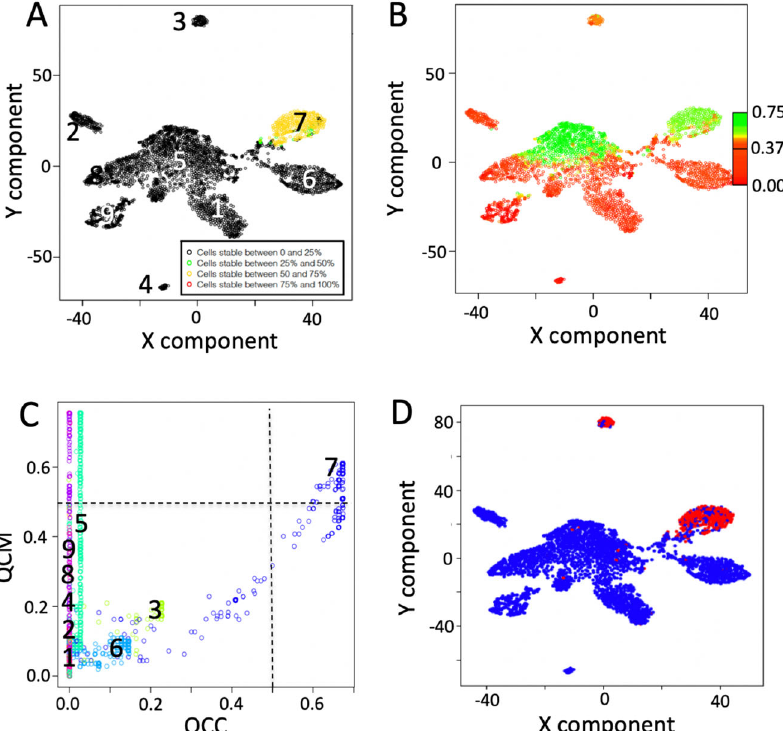
Fig. 7 Information contents extracted by SCA analysis using a TF-based latent space. a QCC. b QCM. c QCM/QCC plot, where only cluster 7 shows, for the majority of the cells, both QCC and QCM greater than 0.5. d COMET analysis of SCA latent space. SOX5 was detected as fi rst top ranked gene speci fi c for cluster 7, using as input for COMET the latent space frequency table. Input counts table for SCA analysis is made by raw